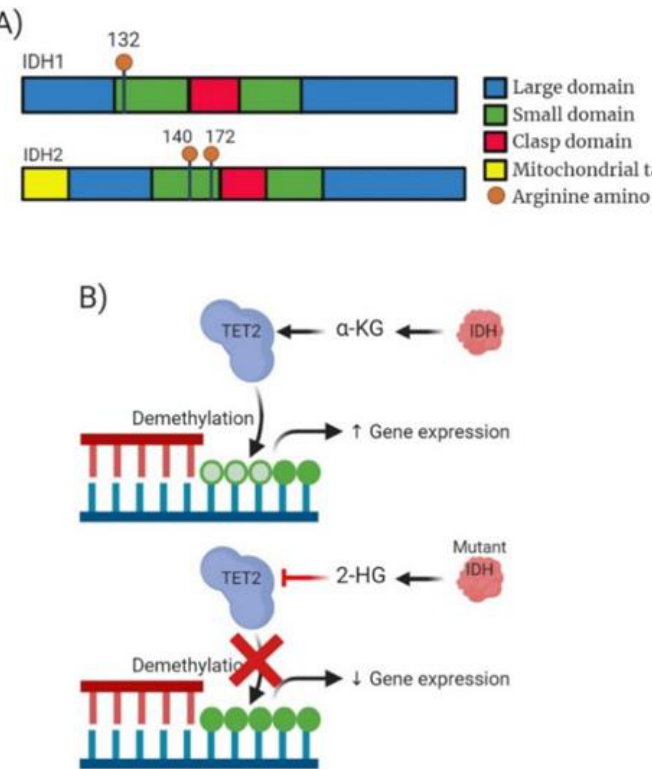
Figure 4. Analysis of IDH molecular structure, mechanism of action and drug target action. ( A ) Domain structure of mammalian IDH1 enzyme consisting of 414 amino acid residues and IDH2 consisting of 452 amino acids. Blue highlighting a large domain. Green highlighting the small domain. Red highlighting clasp domain which links other subunits together. IDH2 also contains a mitochondrial targeting sequence. Additionally, highlighted is the structural position of the most common mutation occurring within IDH1 (R132) and IDH2 (R140/172). ( B ) Mechanism of action for both wild-type IDH and the mutant IDH . WT IDH causing production of α -KG enabling TET2 to function in demethylation of DNA causing potential increased gene expression. Mutated IDH inhibits TET2 function due to production of 2-HG expression often resulting decreased gene expression. Patients presenting with IDH mutations are associated with distinct subsets of AML and normal/intermediate risk cytogenetic groups (27.1% of patients) suggesting that mutant IDH contribution can be linked to cell fate determination at the beginning stages of progenitor differentiation [26]. Clinical presentation includes older patients who present with higher platelet levels. Healthy individuals can also possess IDH mutations suggesting age-related clonal haematopoiesis; also suggesting the presence of IDH mutations in the beginning stages of leukaemogenesis and the requirement for concurrent mutations to enable AML progression. IDH mutations have been observed co-occurring alongside NPM1 mutations and have better prognosis [40]. IDH mutations have shown to be mutually exclusive with TET2 mutations. TET2 , as described above, utilizes α -KG to enable the conversion of 5-mC into either 5-hydroxymethylcytosine (5hmC), 5-formylcytosine